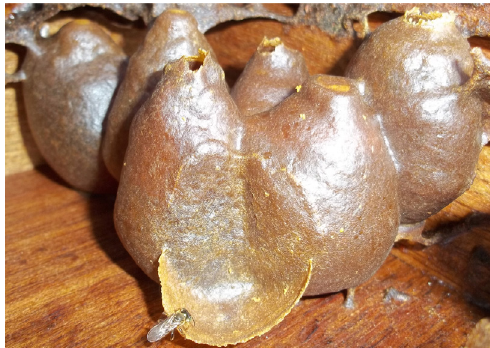
Fig 4 . Superior view of the spiral brood combs of Tetragona clavipes . (Photo: Raoni Duarte)